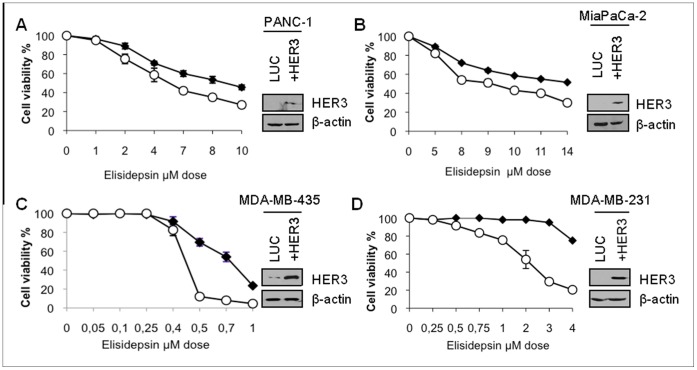
Upregulation of HER3 increases elisidepsin sensitivity.Cell viability after treatment with various concentrations of elisidepsin for 72 h was determined in PANC-1 (A), MiaPaCa-2 (B), MDA-MB-435 (C) and MDA-MB-231 (D) cells. Stable cell lines with an upregulation of HER3 expression (with the pIRES HER3) are shown with white circles while black diamonds are used for LUC-transfected control cells (with the pIRES-LUC). Mean, SD, and IC50 values are shown from three independent experiments. Cell viability was measured by a crystal violet assay. Before performing the viability experiments, all cell lines were checked by western blot using 50 µg of protein to confirm their levels of HER3 expression.